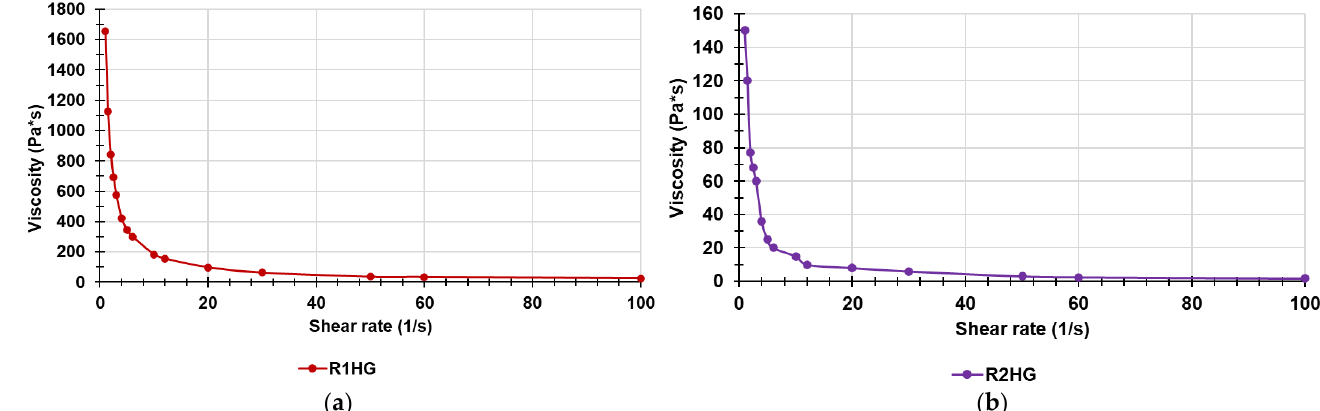
Figure 9. Curve of viscosity vs. shear rate of R1HG ( a ) and R2HG ( b ). The experiments were carried out at r.t.